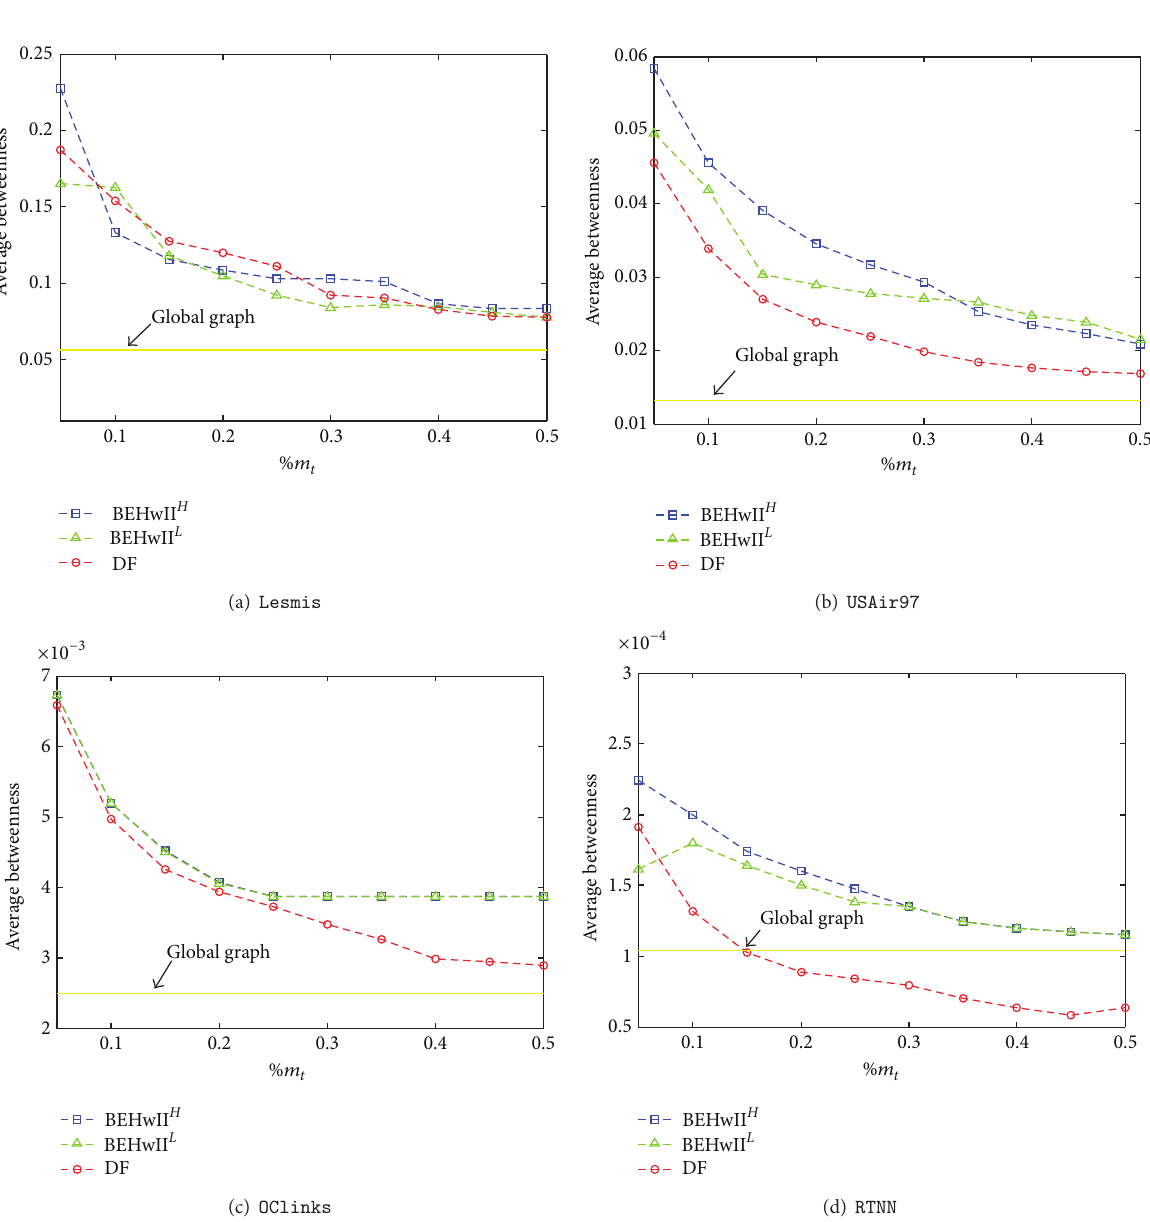
Figure 4: Comparison in terms of the average